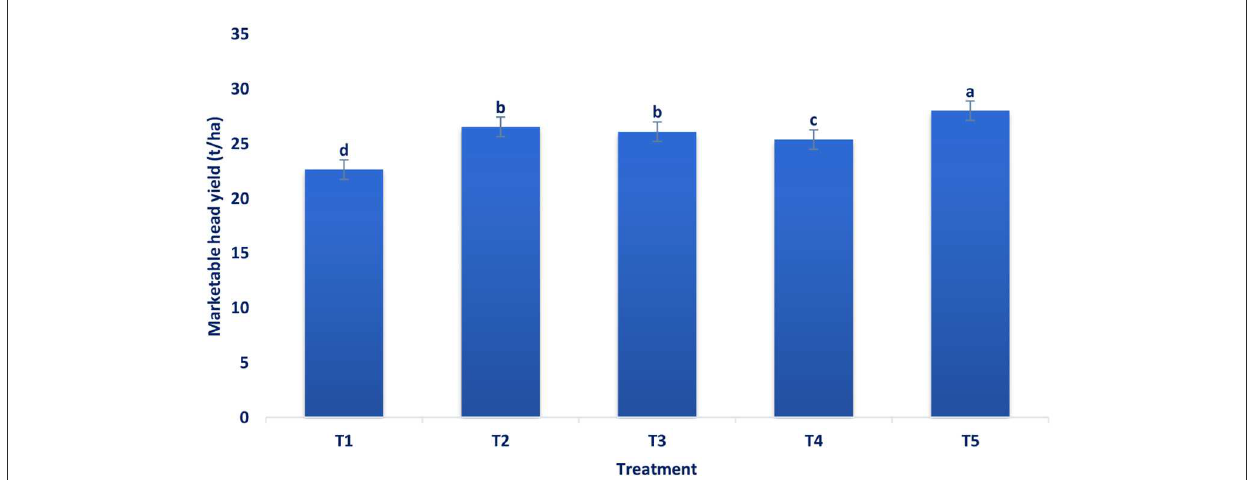
FIGURE3 Influence of pre-harvest foliar application of mineral nutrients on the marketable head yield t ha − 1 of broccoli. T 1 = control, T 2 = B, T 3 = Zn, T 4 = Mo, and T 5 = B + Zn + Mo, 0.40%, respectively.